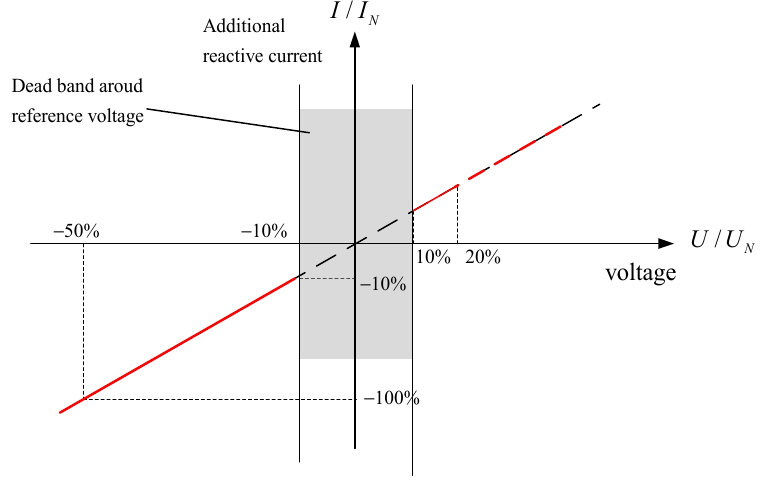
Figure 3. E.ON’s reactive current support requirements [4].